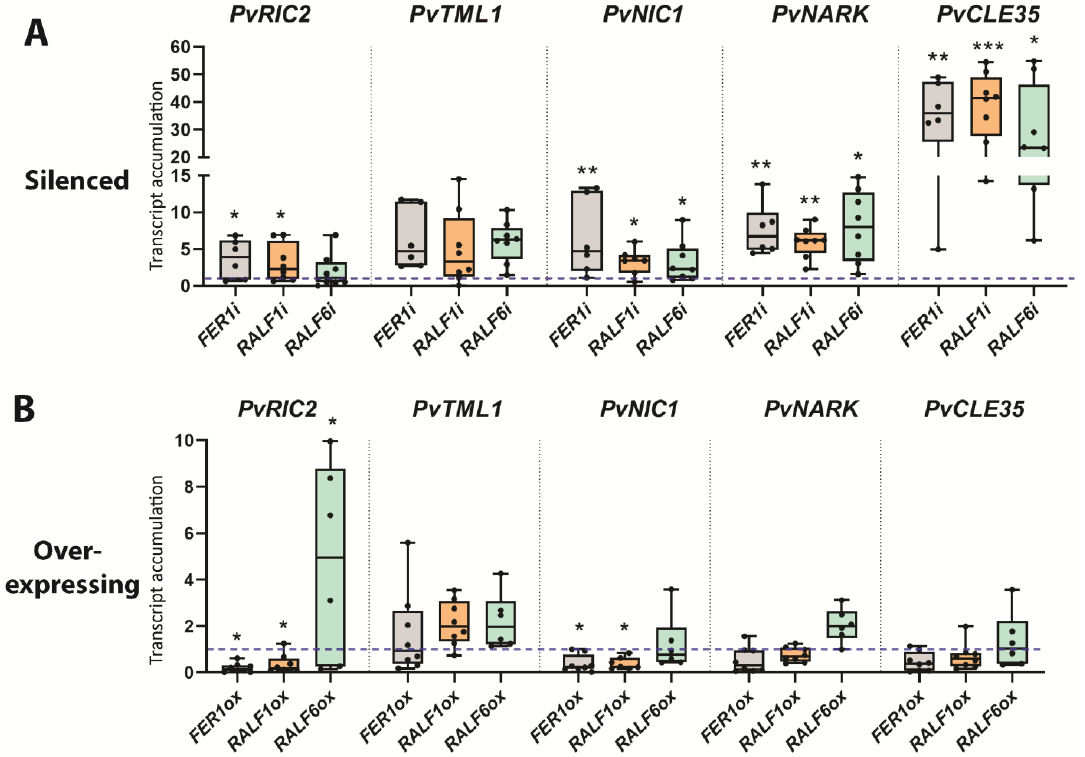
Figure 4. PvFER1 , PvRALF1 , and PvRALF6 negatively regulate the expression of genes related to AON and NRN under low-nitrate conditions. ( A , B ) Transcript accumulation levels of AON ( PvRIC2 and PvTML ) and NRN ( PvNIC , PvNARK , and PvCLE35 ) marker genes in PvFER1 - (gray boxes), PvRALF1 - (orange boxes), and PvRALF6 -silenced (green boxes) ( A ) or -overexpressing ( B ) transgenic roots at 21 dpi under low-nitrate conditions. The blue dotted lines represent the levels of the transcripts in the control roots for the five genes analyzed. The upper and lower edges of the boxes delimit the first to third quartiles, the horizontal line within the box represents the median, and the whiskers indicate the smallest and largest outlier in the data set. Data from three independent experiments are plotted as dots ( n ≥ 8). Accumulation levels of IDE transcript were used as the reference. A non-parametric Mann–Whitney test was used to assess significant differences (* p < 0.05, ** p < 0.01, *** p <